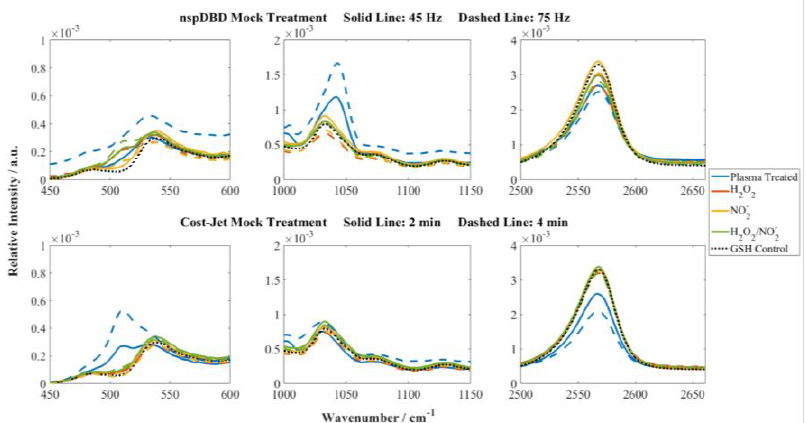
Figure 8. Raman spectra analysis of plasma-treated GSH showed more pronounced peaks than mock treatment. GSH was mixed with H 2 O 2 , NO 2 − , or their combination. The spectra were plotted against their corresponding plasma treatment counterparts. The spectra were centered on the observed modifications from plasma treatment: increased in the ν (S-S) (508/522 cm − 1 ) and ν (S=O) (1045 cm − 1 ) bands with a decrease in the ν (S-H) (2560 cm − 1 ) band. For both the nspDBD and the COST-Jet, stronger plasma treatment resulted in more pronounced modifications. ( Top Row ) The nspDBD treatment of GSH resulted in a decrease in the ν (S-H) band and an increase in the ν (S=O) band with no change in the ν (S-S) band. The H 2 O 2 only and the combined mock treatment at these conditions reduced the ν (S-H) band with a slight increase in the ν (S-S) band, which indicated slight oxidation of the GSH. There was no discernable difference in modifications between the NO 2 − treatment when compared with the untreated control. ( Bottom Row ) The COST-Jet-treated samples showed a decrease in the ν (S-H) band and an increase in the ν (S-S) band. There was no increase in the ν (S = O) band. The mock treatment samples did not modify the GSH when compared to the